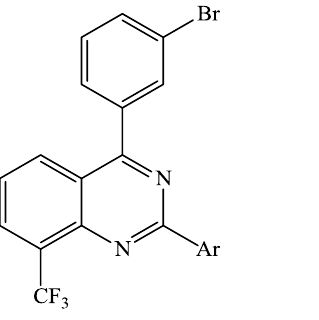
Figure 3. Examples of biologically active 4-aryl- 7 and 4-alkynylquinazolines 8